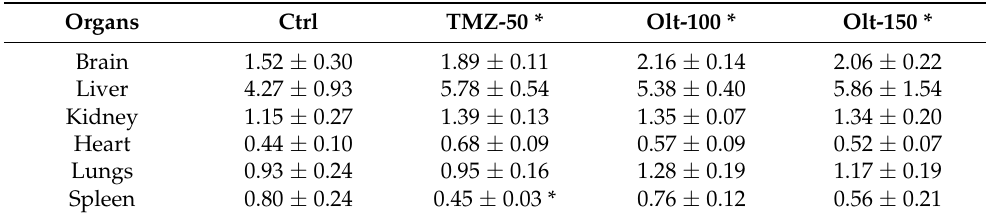
Table 2. Relative organ weight (g%) of tumor-bearing mice administered with the Olt for 21 days post-sacrifice.